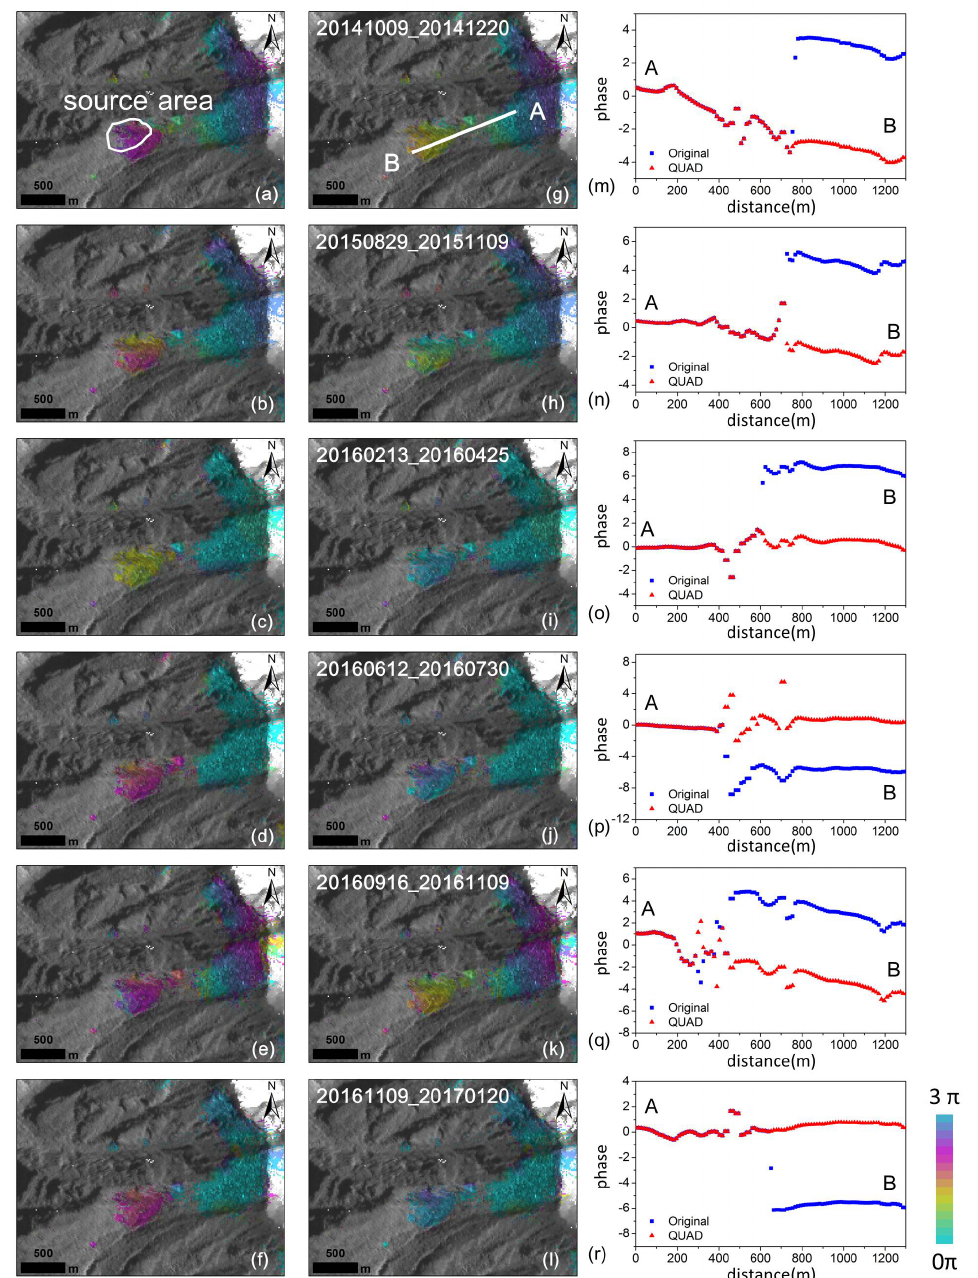
Figure 5. (a)- (f) are the original unwrapped interferograms, (g)-(i) the corrected unwrapped interferograms, (m)-(r) are crossections of the unwrapped phase before and after the correction along the profile